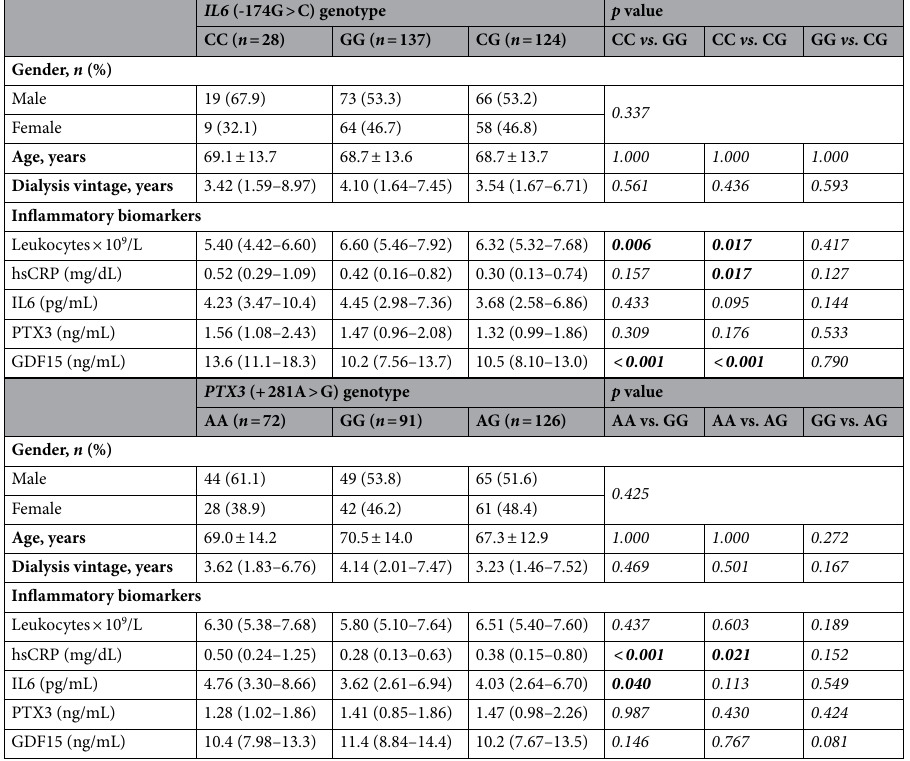
Table 4. Gender, age, blood levels of leukocytes, IL6, hsCRP, PTX3 and GDF15, according to the IL6 and PTX3 polymorphic genotype in end-stage renal disease patients ( n = 289). Data are presented as mean ± standard deviation or as median (interquartile range). Multiple comparisons between genotypes were performed by the Mann–Whitney U test, by the one-way Anova with Bonferroni post-hoc tests or by the Pearson’s Chi-square test, as appropriate. Italic denotes p -values and bold-italic statistically significant p- values. GDF15 growth differentiation factor 15, hsCRP high-sensitivity C-reactive protein, IL6 interleukin 6, PTX3 pentraxin